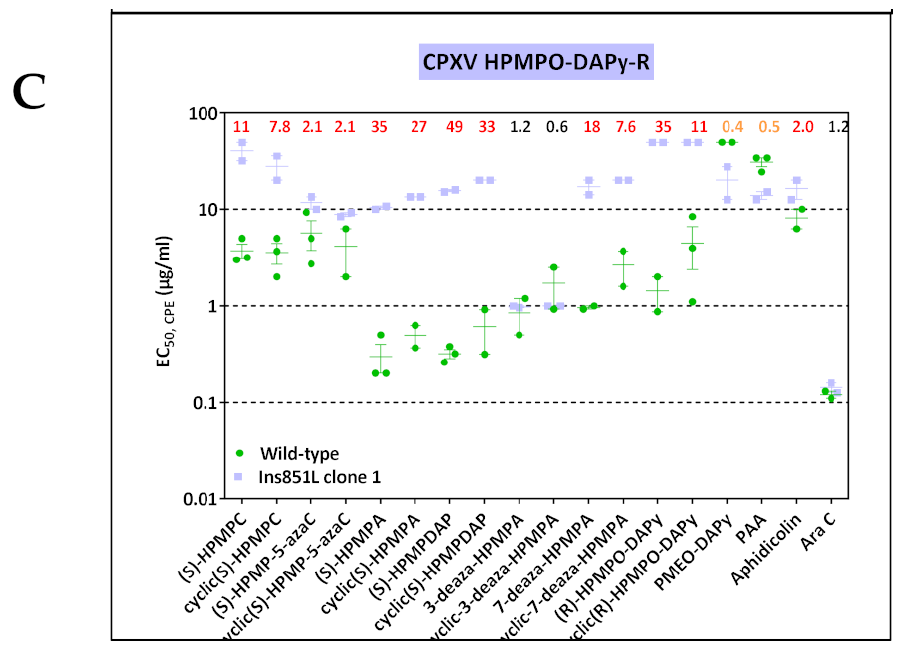
Figure 2. Drug-susceptibility profile of HPMPC-R ( A ), HPMPDAP-R ( B ), and HPMPO-DAPy-R ( C ) clones isolated from CPXV Brighton strain. Drug-resistance properties of different plaque-purified viral clones bearing the indicated DNA pol mutations as determined using a CPE reduction assay with HEL fibroblasts. The effects of different drugs on viruses encoding the indicated mutations were determined by calculating the EC 50 values for the parental wild-type strain and clones bearing the specific mutations. At least two independent experiments were performed for each test compound. Horizontal lines for each drug and mutant indicate the mean values ± standard deviation. The fold resistance (ratio of the EC 50 for the mutant virus to the EC 50 for the wild-type CPXV strain) is marked at the top of the graph. CPXV viral clones showing a ≥ 2-fold increase (red, bold) were considered drug resistant (R) and those with a ≤ 0.5-fold decrease (orange, bold) drug hypersensitive (hs). For CPXV HPMPDAP-R, the fold resistance for the Ins408 + L924F mutant is indicated in the upper part of the figure line, while for the L924F mutant these numbers are shown underneath the previous ones. Table 2. Identification of amino acid changes in the CPXV Brighton strain DNA polymerase following selective pressure with HPMPC, HPMPDAP, and